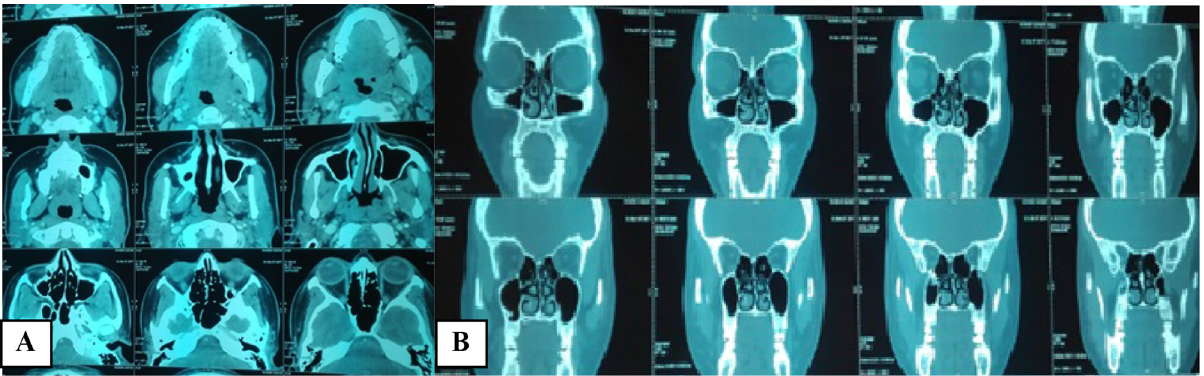
Fig. 2. Computed tomography scan: A. Axial. B. Frontal slices: no bone spread was